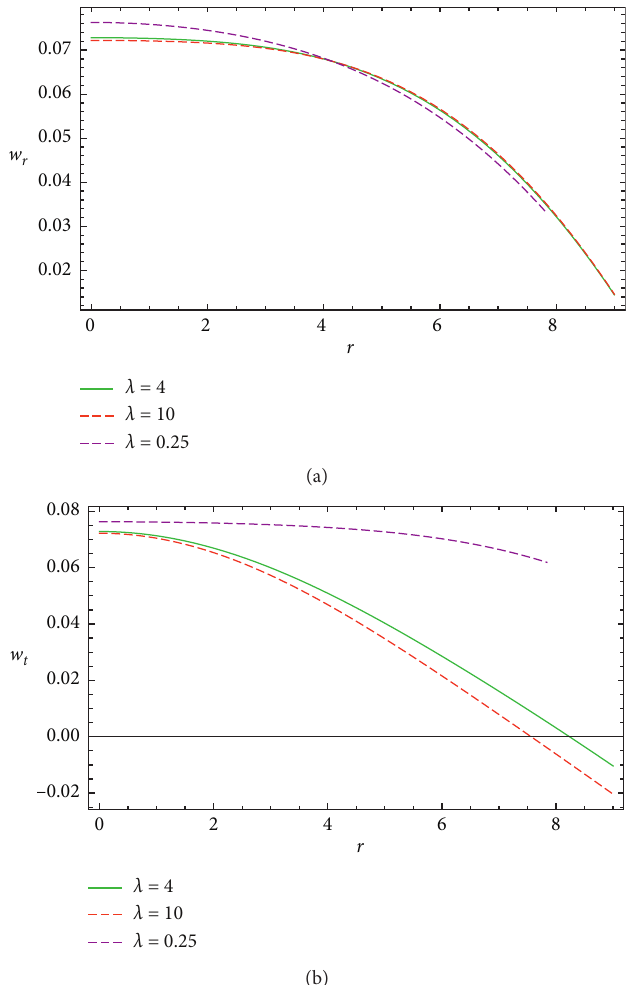
Figure 14: Left and right panel of the figure show the behavior of w